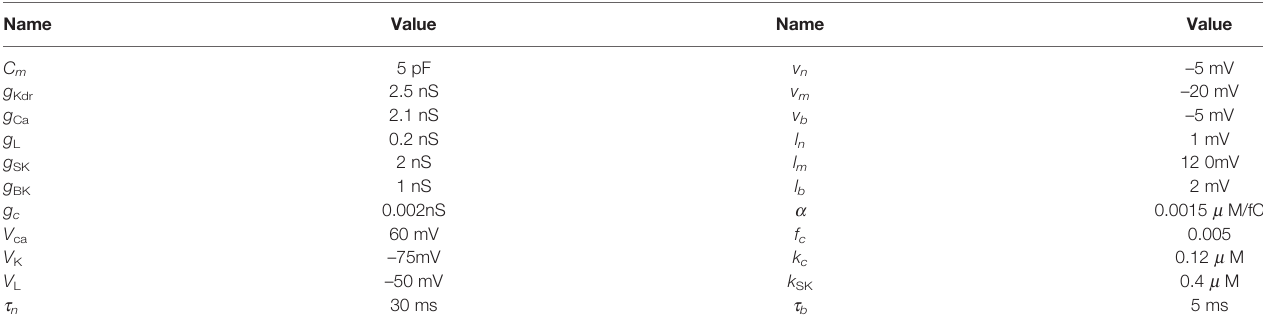
TABLE 1 | Model parameter values for each model